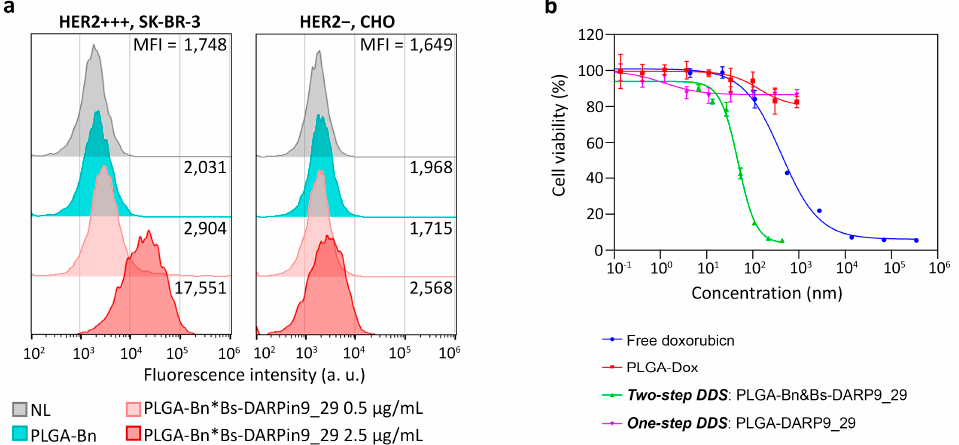
Figure 10. Targeted delivery and cytotoxicity of two-step DDS, PLGA-Bn*Bs-DARPin9_29. ( a ) Flow cytometry of SK-BR-3 and CHO cells, labeled with PLGA-Bn*Bs-DARPin9_29 nanostructures in the fluorescence channel FL4 corresponding to Nile Blue fluorescence. ( b ) Cytotoxicity of free doxorubicin, non-targeted PLGA loaded with doxorubicin, and targeted one-step DDS (PLGA-DARPin9_29) and two-step DDS (PLGA-Bn*Bs-DARPin9_29) based on PLGA particles, obtained with the MTT assay.